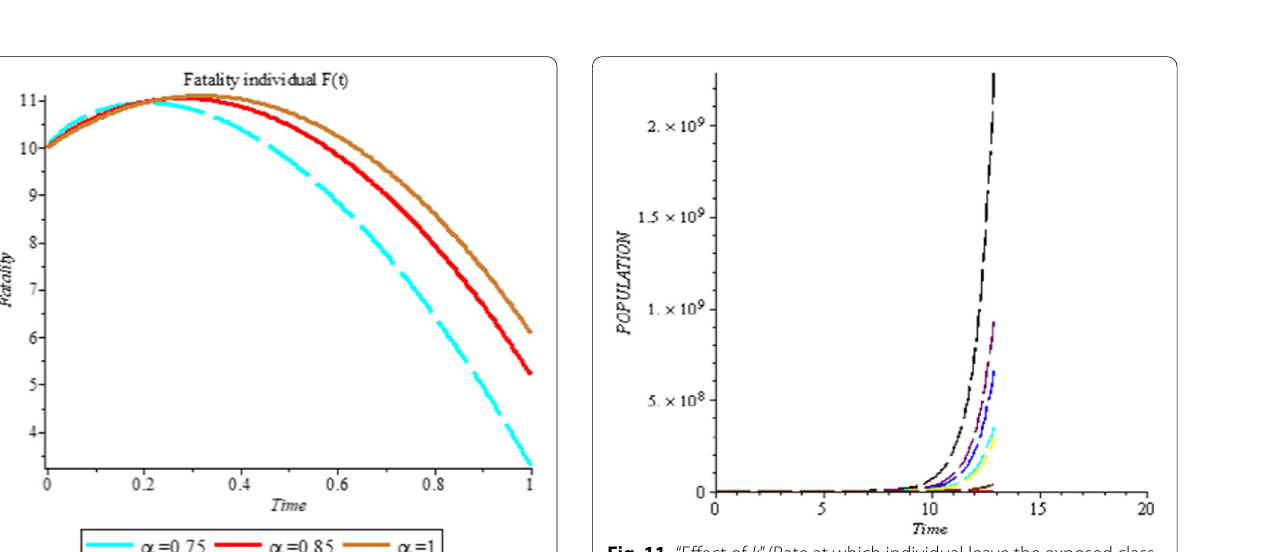
Fig. 11 “Effect of k ” (Rate at which individual leave the exposed class on S , V , E , I , P , A , H , R , F